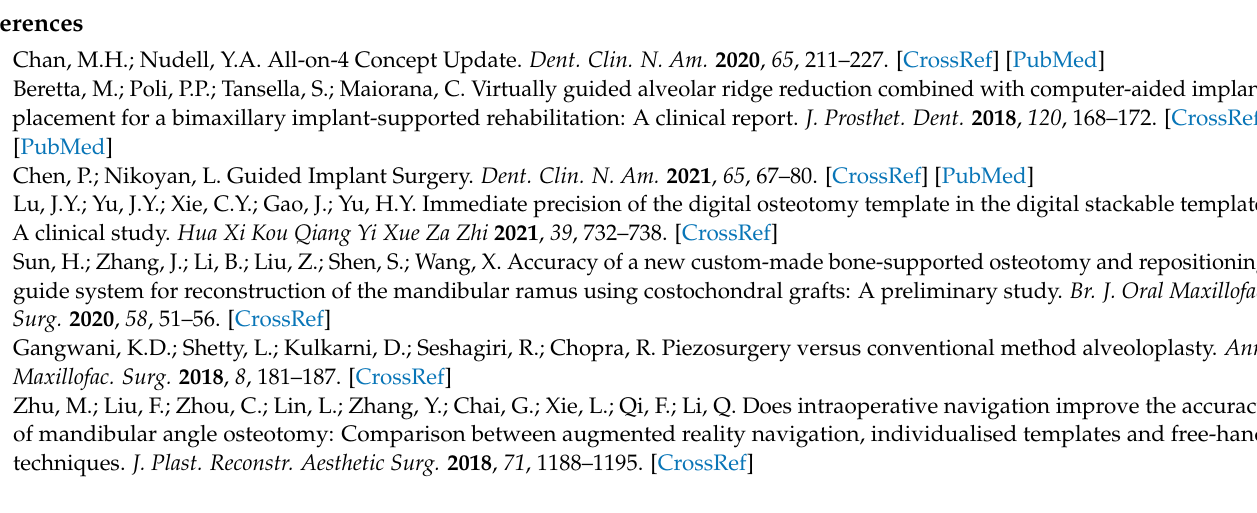
Figure 20. Comparison between digital plan and post-op CBCT.